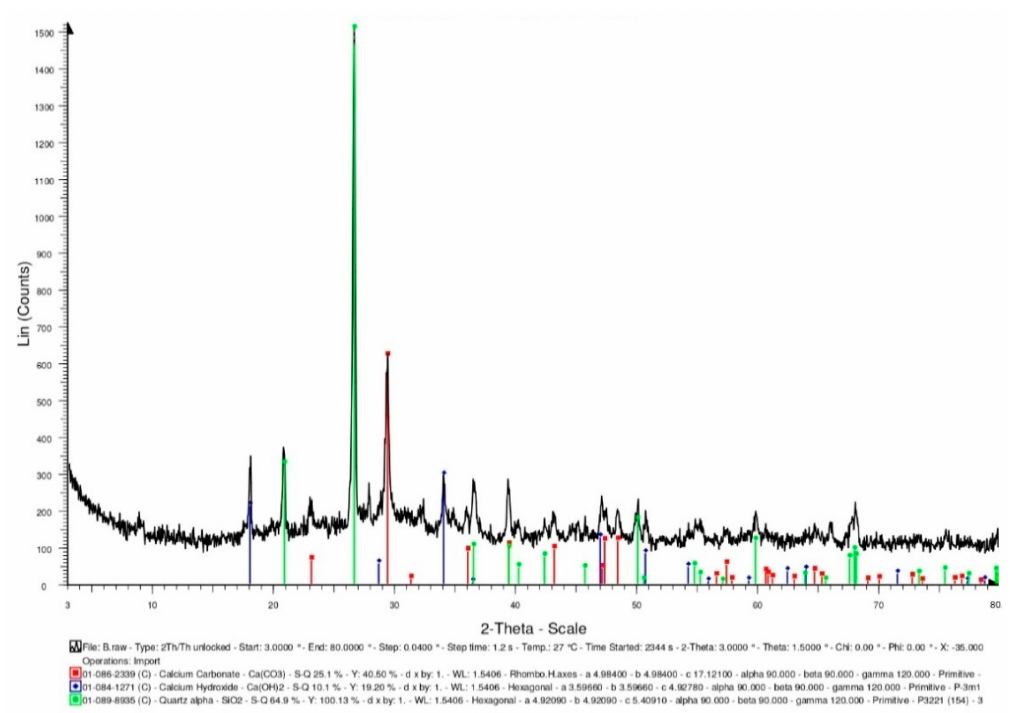
Figure 16. XRD-analysis results of the experimental group specimen.